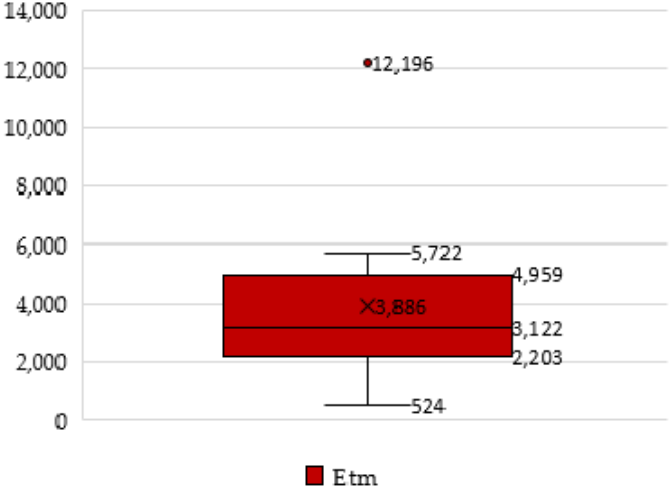
Figure 5. Total energy accumulated in the tractors, machines and tools used [MJ · ha − 1 ]. Source: own study.